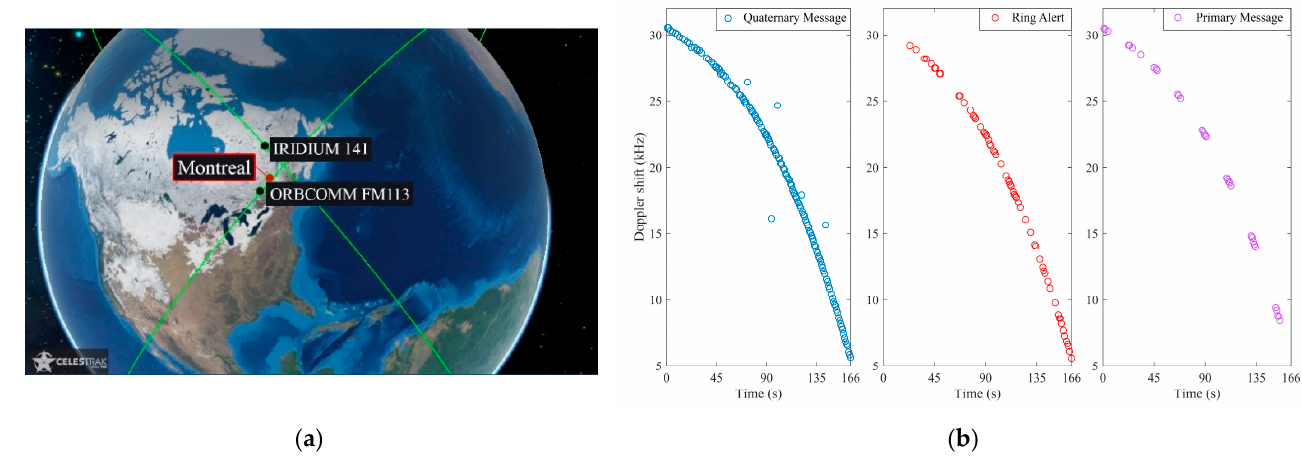
Figure 6. ( a ) Geographical view of the overhead satellites. ( b ) Tracked Doppler shifts from the Iridium 141 in three different channels: quaternary message, primary message, and ring alert.